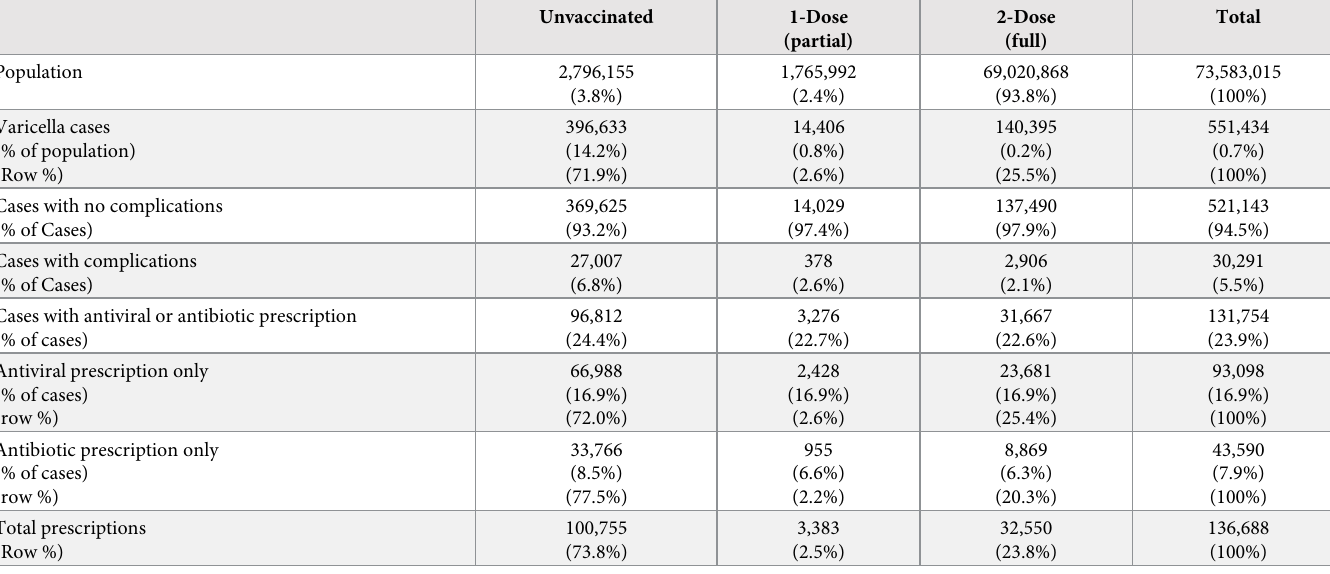
Table 1. Estimated annual varicella cases, antibiotic prescriptions and antiviral prescriptions in the US population under 18 years old by vaccination status, base case.